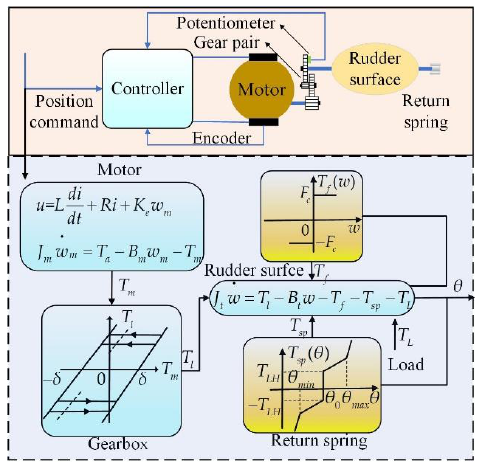
Figure 2. Block diagram of the electric rudder system and information transmission process.